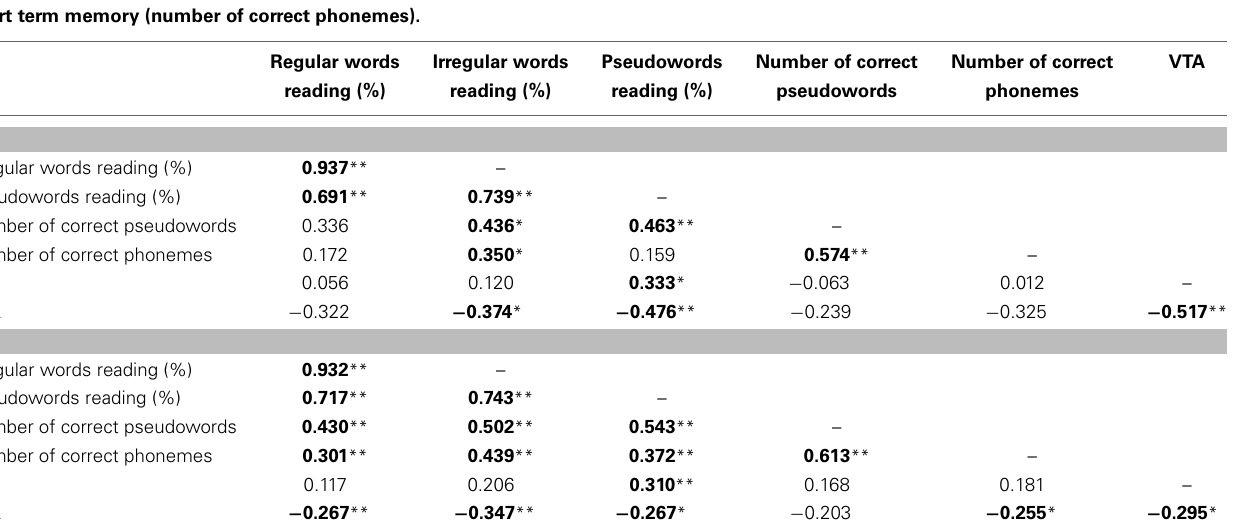
Table 5 | Bivariate correlations between abilities were measured on Regular and Irregular words and Pseudowords, time-course of visual spatial attention (VSA; RT difference between cuing effect at 350 and 100ms SOA), time-course of visual temporal attention (VTA; identification accuracy mean in O + noise condition), pseudowords phoneme blending (number of correct pseudowords), and a pseudoword short term memory (number of correct phonemes).